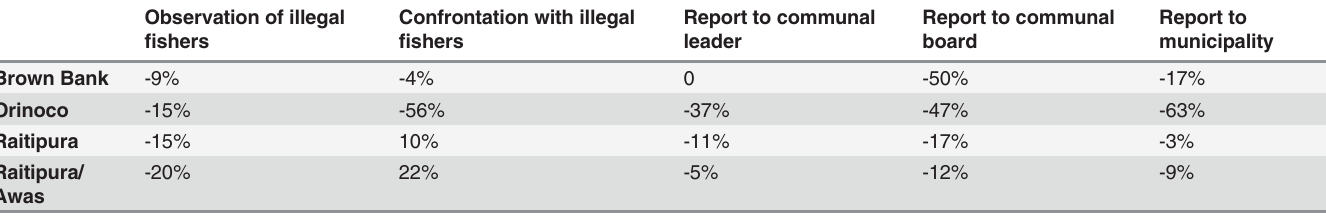
Table 2. Percent change in specific individual enforcement actions from 2011 – 2012. Observation of illegal fi shers